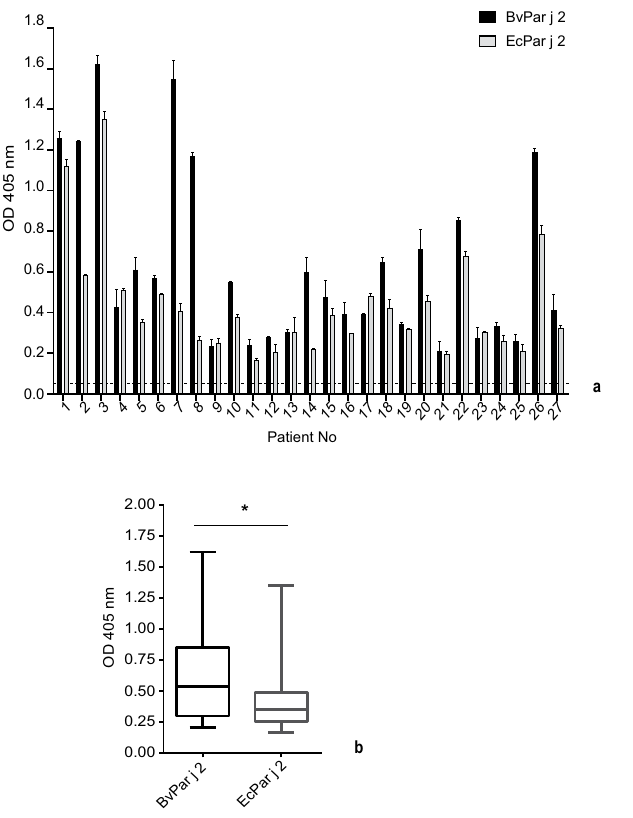
Figure 4. IgE reactivity of BvPar j 2 (black) and EcPar j 2 (grey) demonstrated by ELISA. IgE reactivity (y-axis: mean OD values + / − SD) of sera from 27 Parietaria allergic patients (x-axis) to BvPar j 2 and EcPar j 2. The buffer control was subtracted from the data and cut-off is represented by dashed line. (a) Box plot representation (whiskers = minimum and maximum; boxes = 25 th to 75 th percentiles, means: horizontal bars) of the IgE reactivity of the above sera to BvPar j 2 and EcPar j 2. (b) Statistically significant differences are indicated ( * P <